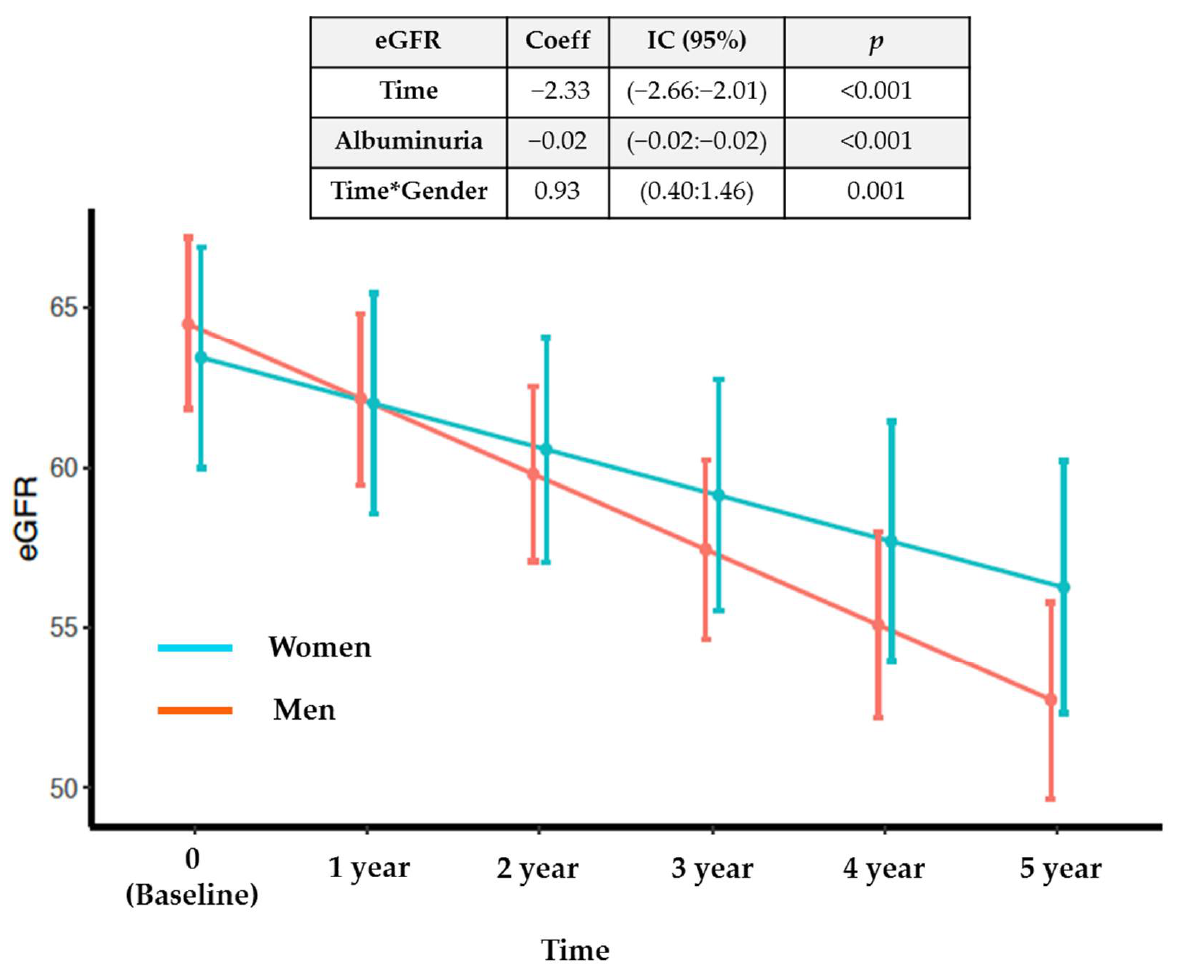
Figure 2. Evolution of estimated glomerular filtration rate (eGFR) by sex, adjusted by albuminuria, Time and Gender interaction (Time*Gender) in the mixed linear model, and its graphical representation of the mean eGFR between sexes.